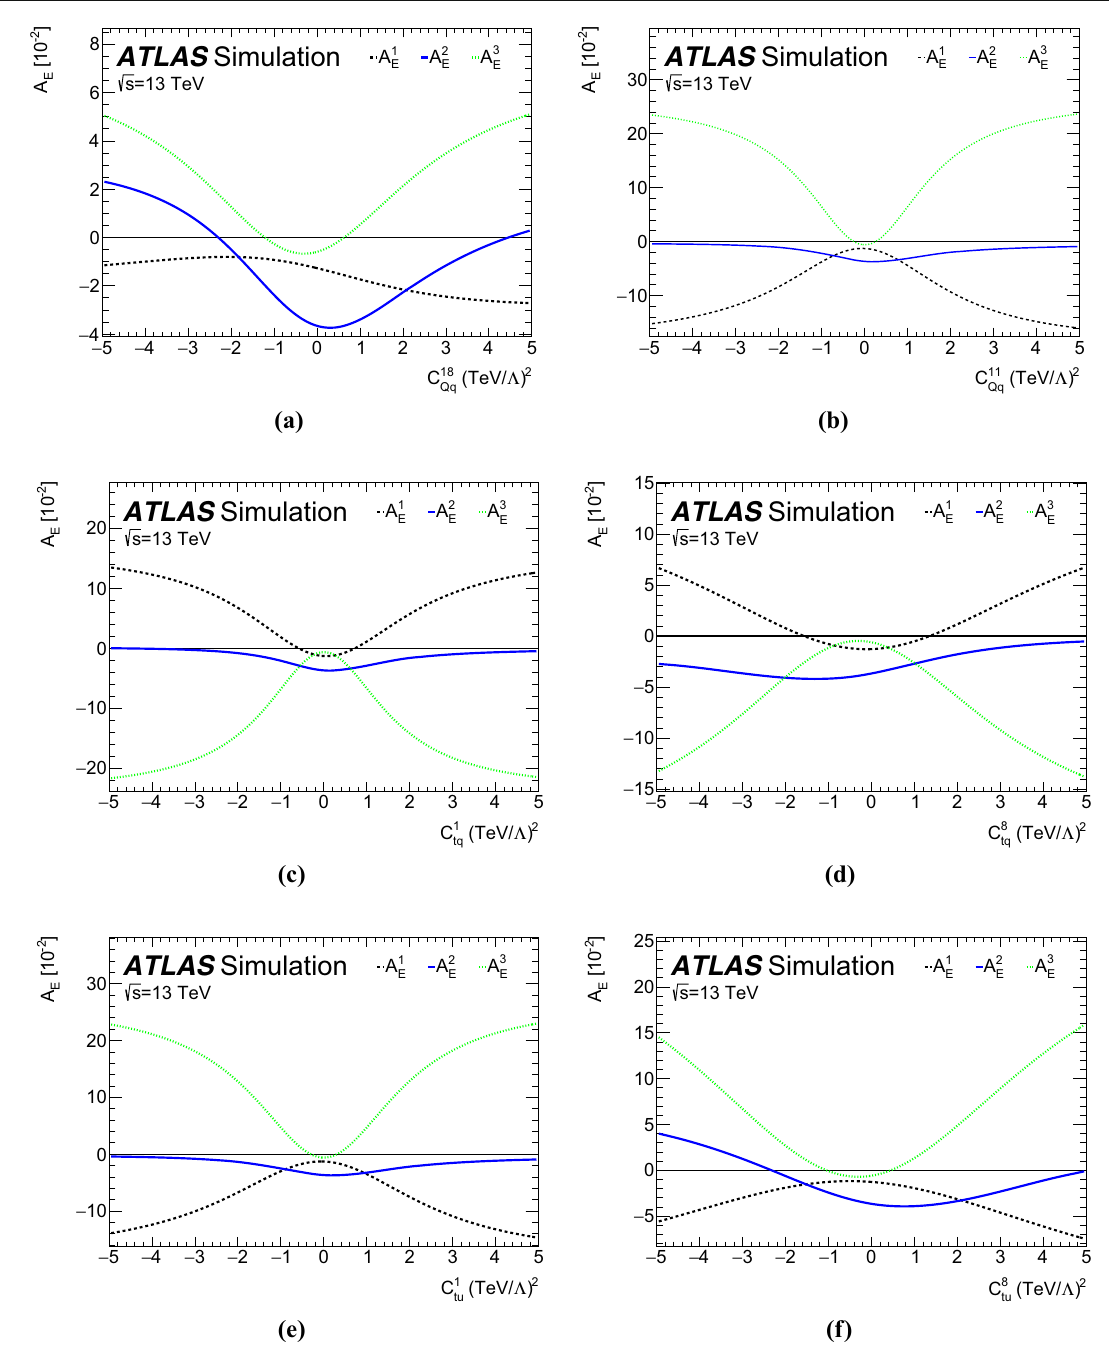
Fig. 8 Energy asymmetry A E in three θ j bins, A 1 coefficients. In each sub-figure, only one coefficient is considered, while all other coefficients are set to zero Correlations among the measurements and among the pre- dictions are taken into account by the covariance matrix C = C d + C t , C t = C MC stat + C scale , which contains the measurement uncertainties C d and the prediction’s theoretical uncertainties C t due to both the MC sample size, C MC stat , and the renormalisation and